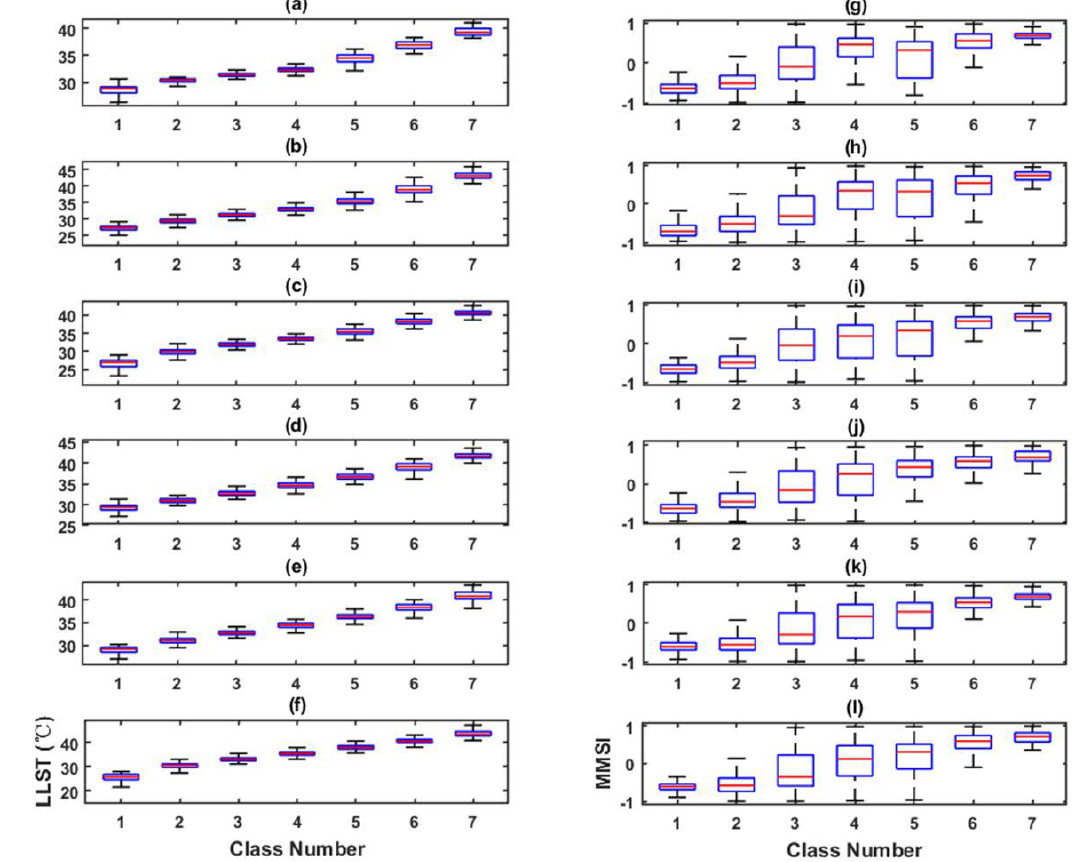
Figure 10. The boxplots of the spatial classification results. LLST of ( a ) 2002, ( b ) 2005, ( c ) 2008, ( d ) 2011, ( e ) 2014, ( f ) 2017; MSSI of ( g ) 2002, ( h ) 2005, ( i ) 2008, ( j ) 2011, ( k ) 2014, ( l ) 2017.